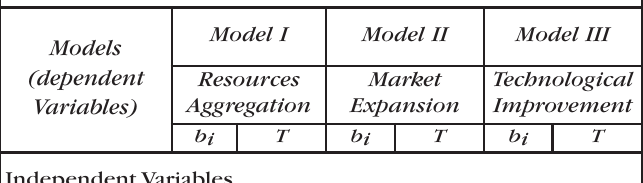
Table 4. Summary of Regression